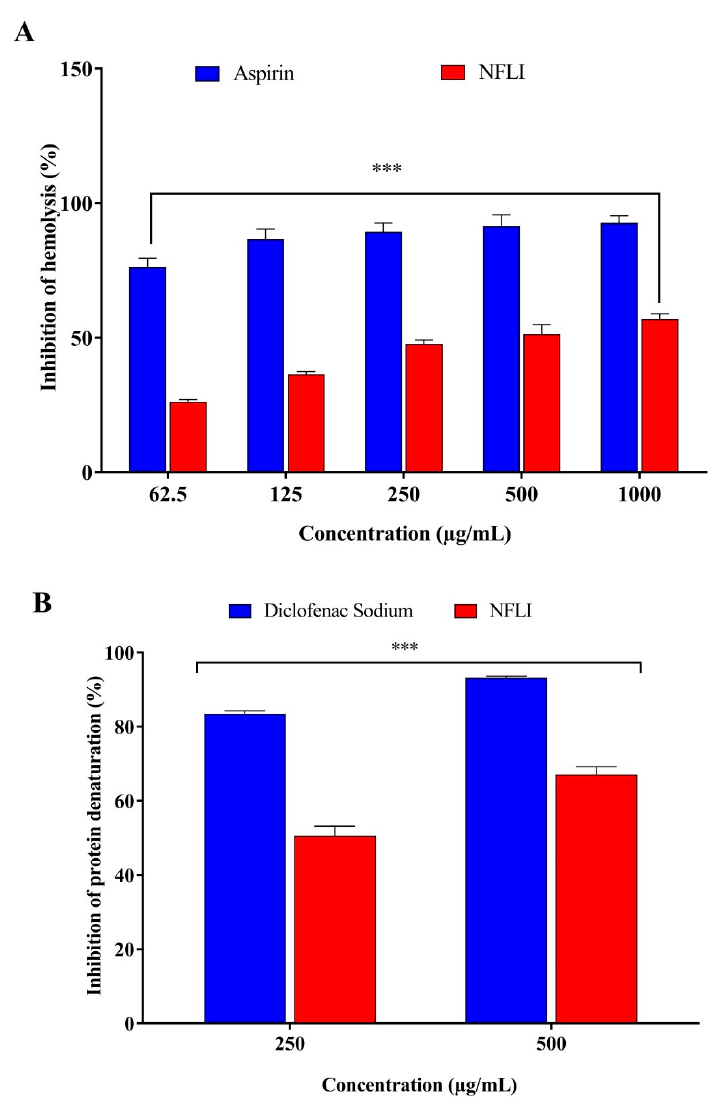
Figure 1. Anti-inflammatory activity of n -hexane fraction of L. indica (NFLI). ( A ) Membrane stabilisation effect of the n -hexane fraction of L. indica (NFLI) compared with aspirin. ( B ) Percentage inhibition of protein denaturation of the n -hexane fraction of L. indica (NFLI) compared with diclofenac. Results are expressed as mean ± SEM, with *** p < 0.001 considered significantly different to the positive control group following one-way ANOVA (Dunnett’s